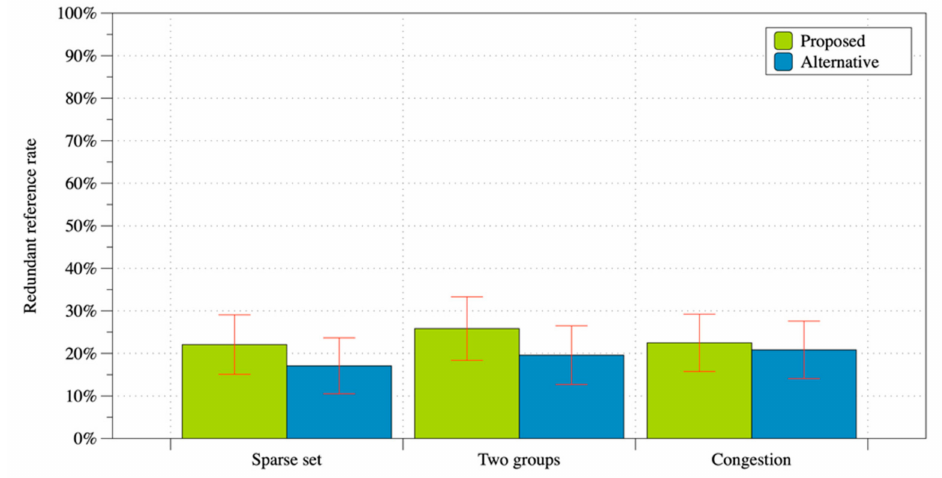
Figure 13. Rates of redundant reference per